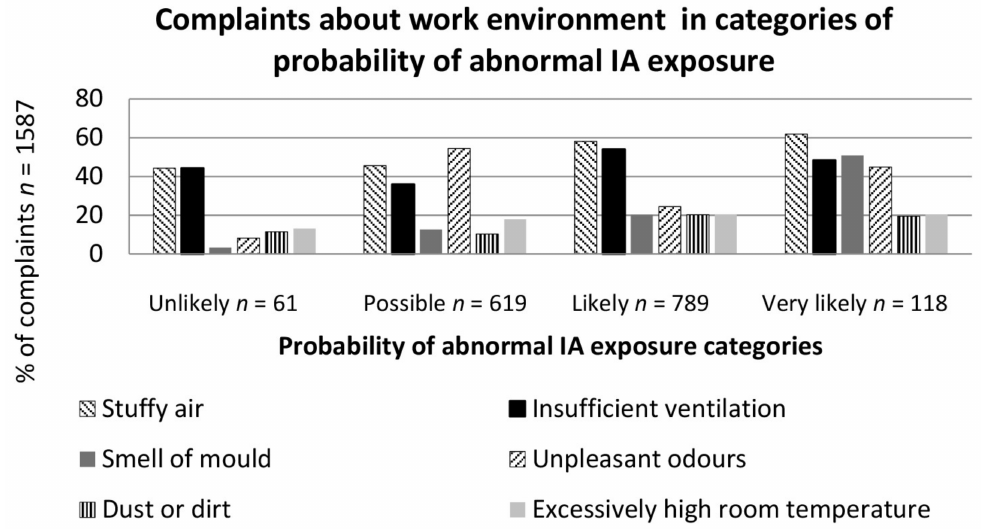
Figure 2. Categories of probability of abnormal IA exposure and employees’ complaints about their work